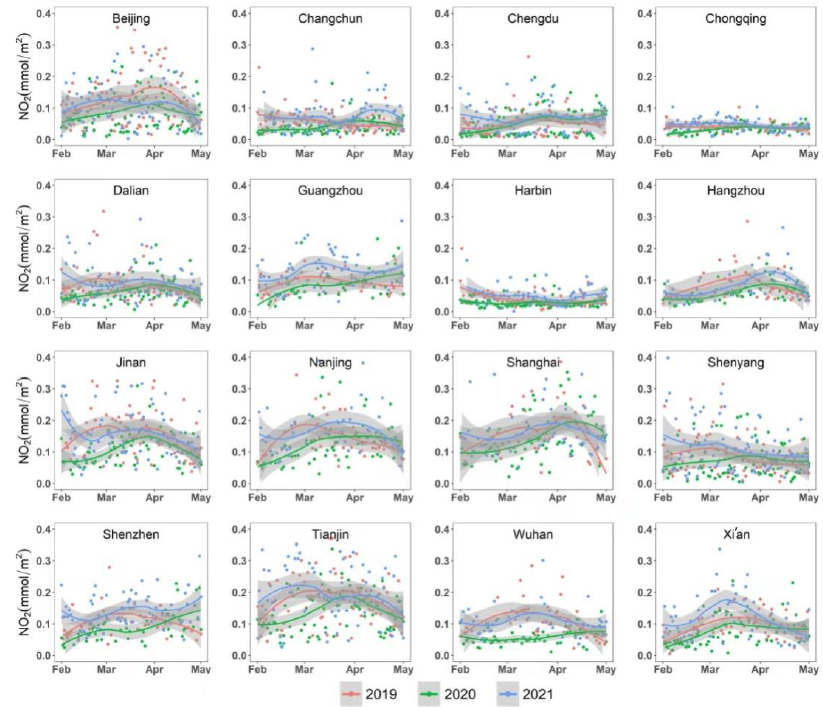
Figure 3. Temporal variation of NO 2 concentrations in 16 metropolitan areas from February 1 to May 1 in 2019, 2020, and 2021 across the selected lockdown stages. The dots in red, green, and blue colors indicate the values of NO 2 concentrations in 2019, 2020, and 2021, respectively. The lines and the shaded grey areas refer to the fitted curves modeled by the loess model, with its 95% confidence interval.